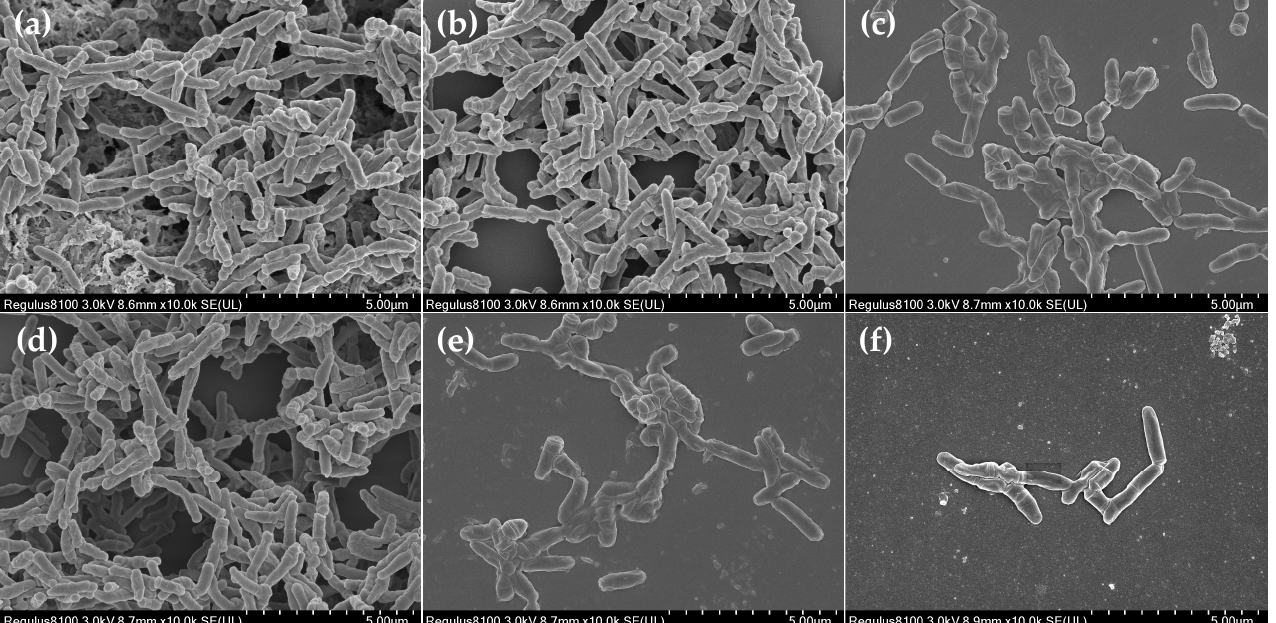
Figure 2. SEM analysis of T. pyogenes (BMH06-3) biofilm co-incubated with luteolin for 72 h. ( a ) Blank control biofilm. ( b ) Solvent control biofilm (1% DMSO). ( c ) Biofilm co-incubated with ceftiofur (0.25 ng/mL). ( d – f ) Biofilm co-incubated with luteolin (39, 78 and 156 µ